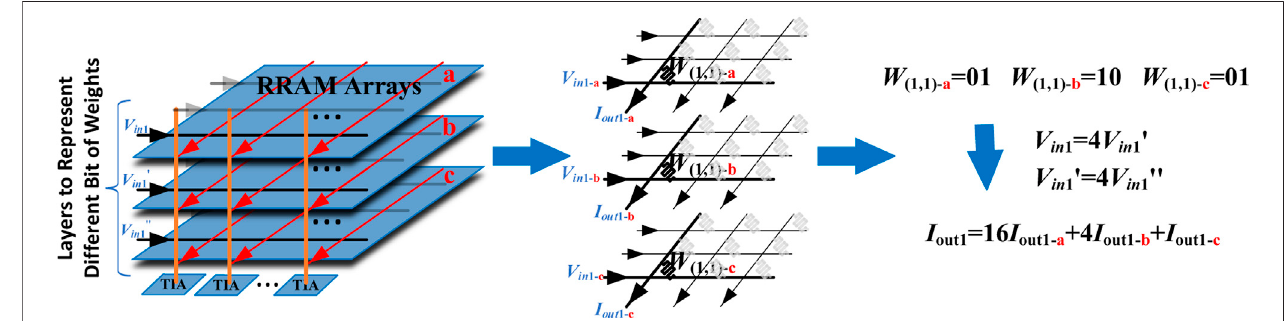
FIGURE 4 | Diagram of using multiple RRAMs to extend the precision of one weight value. Here, three 2-bit cells are utilized to represent a weight value of 6-bit precision, and the input voltages are scaled to different weights of each cell.